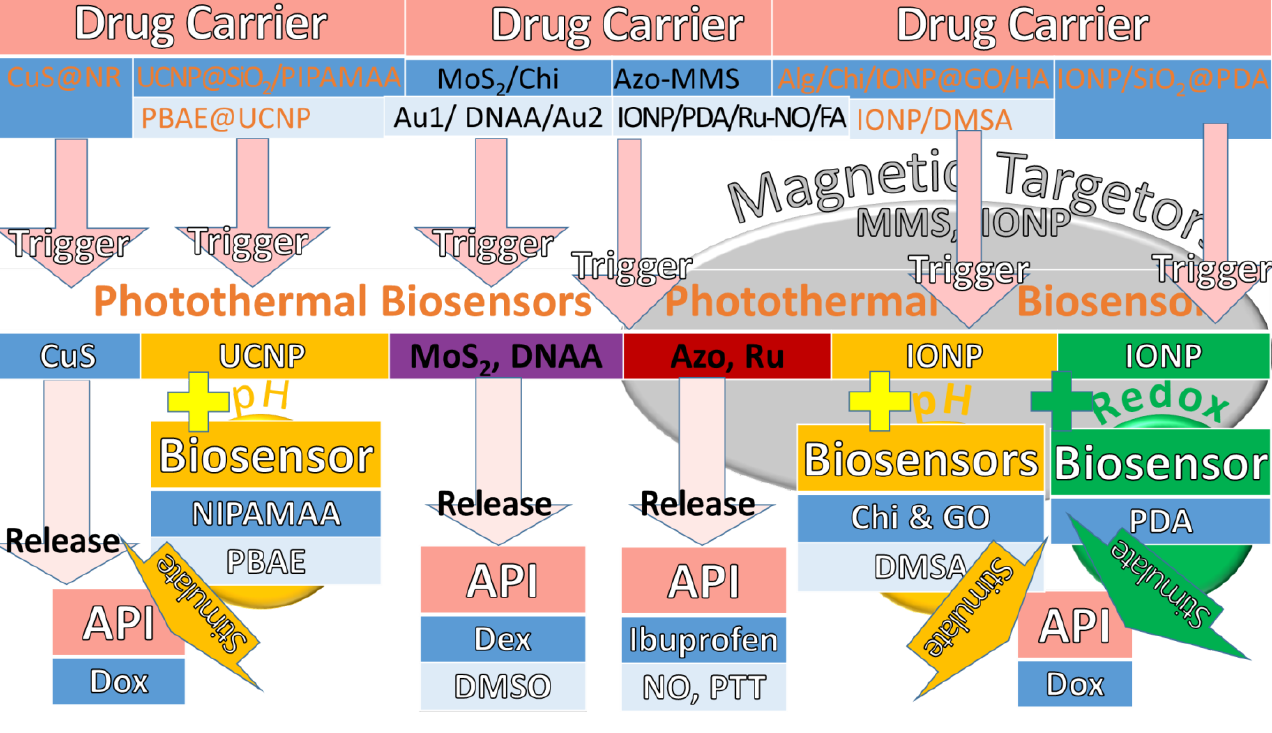
Figure 3. The photothermal triggers with magnetic targetors add redox and pH biosensors in drug carriers to release API. The first and second flows from drug carriers to API are shown in dark blue and light blue, respectively.